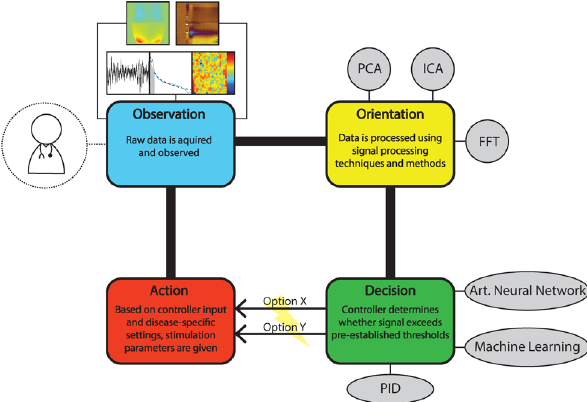
Figure 1: Depiction of a closed-loop DBS system utilizing the OODA loop framework. Abbreviations: PCA – principle component analysis; ICA – independent component analysis; FFT – fast Fourier transform; PID –